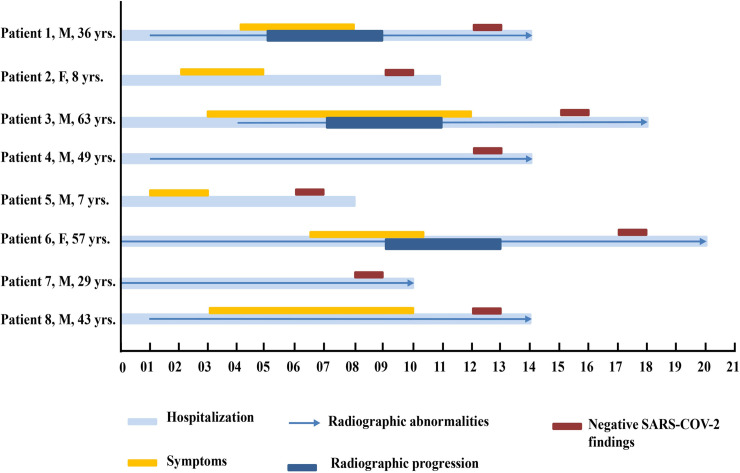
Chronology of symptoms, radiographic findings of the eight COVID-19 patients who developed symptoms or signs during follow-up.The numbers on the bottom indicate the number of days since admission. yrs, years old.